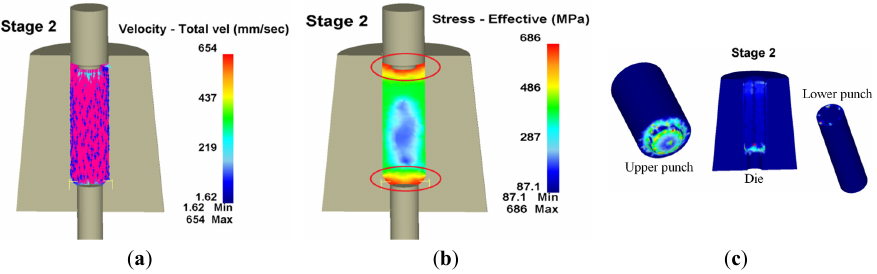
Figure 10. Velocity, effective stress and wear distribution of the second stage in 3D. ( a ) Velocity; ( b ) Effective stress; ( c ) Wear.